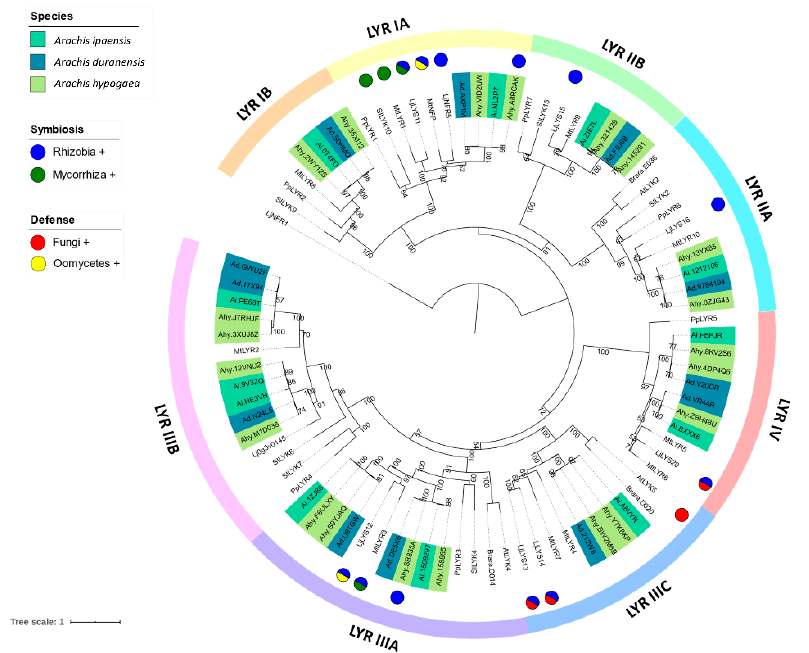
Figure 2. ML phylogenetic tree of LYRs. Different phylogenetic groups are shown. One LYK protein (LjNFR1) was used as an outgroup sequence. The best model fitting the alignment was JTT+I+G+F, gama = 1.916, p-inv = 0.023. Participation of the receptors in rhizobial or mycorrhizal symbioses and defense against bacteria, fungi or oomycetes is indicated using the symbol code. The tree was drawn using iTol.